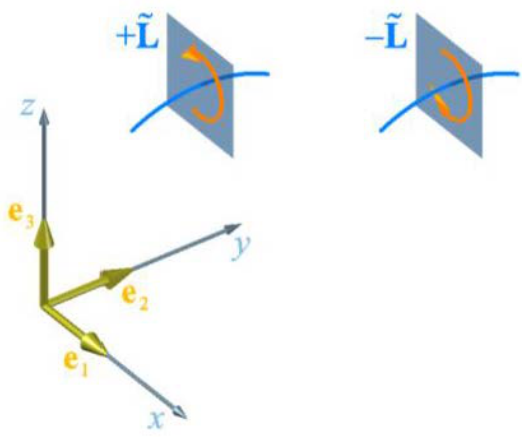
Figure 25: Positive and negative outer orientations of a curve.